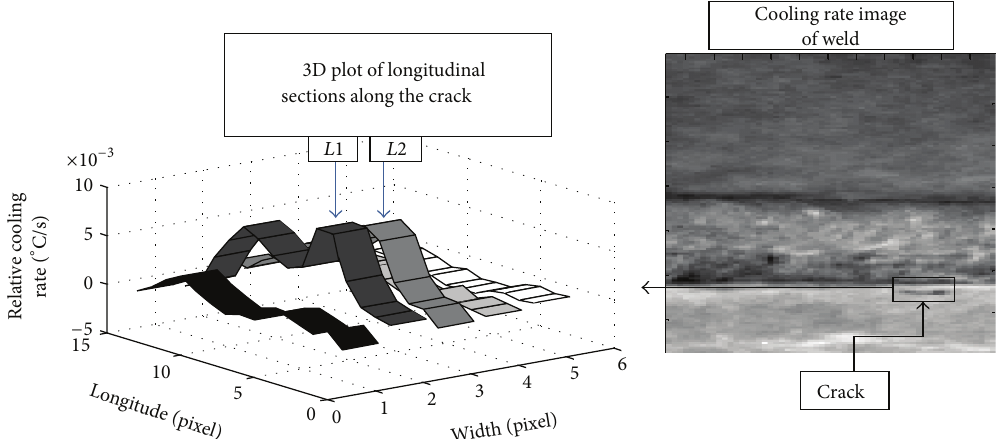
Figure 5: 3D representation of the crack zone based on the relative cooling rate matrix obtained following the procedure illustrated by Figure 3. In Figure 6, the two pixel rows of the crack ( 𝐿1 and 𝐿2 ) are